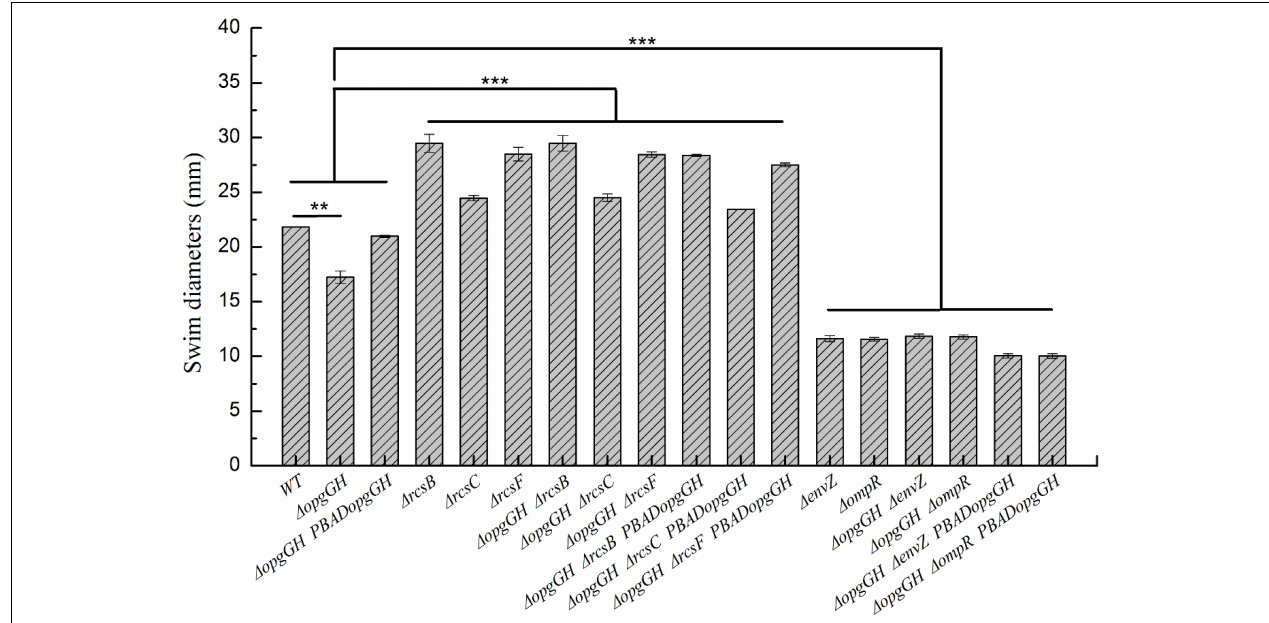
FIGURE 3 | Changes in swim motility of wild-type and mutant strains in LNNS medium. Y. enterocolitica was grown in LNNS semisolid plates supplemented with 0.6 g/L L -arabinose at 26 ◦ C. Swim diameters were measured after 48 h of incubation. The data are presented as the mean ± SD of at least three independent